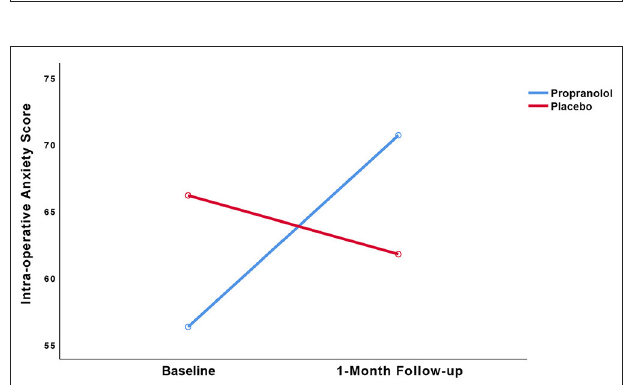
session, extinction rather than reconsolidation is likely to